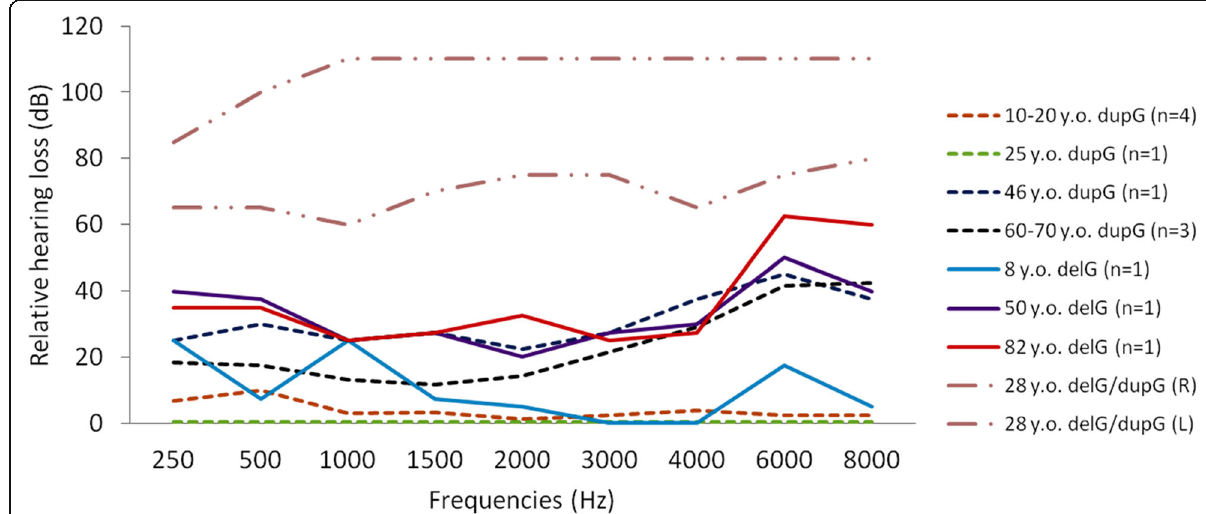
Fig. 3 Air conduction audiograms in heterozygous carriers of codons 12/13 GJB2 mutations at various ages. Line = interrupted: c.35dupG; continuous: c.35delG. Compound heterozygous c.35dupG/c.35delG: L , left ear (upper); R , right ear